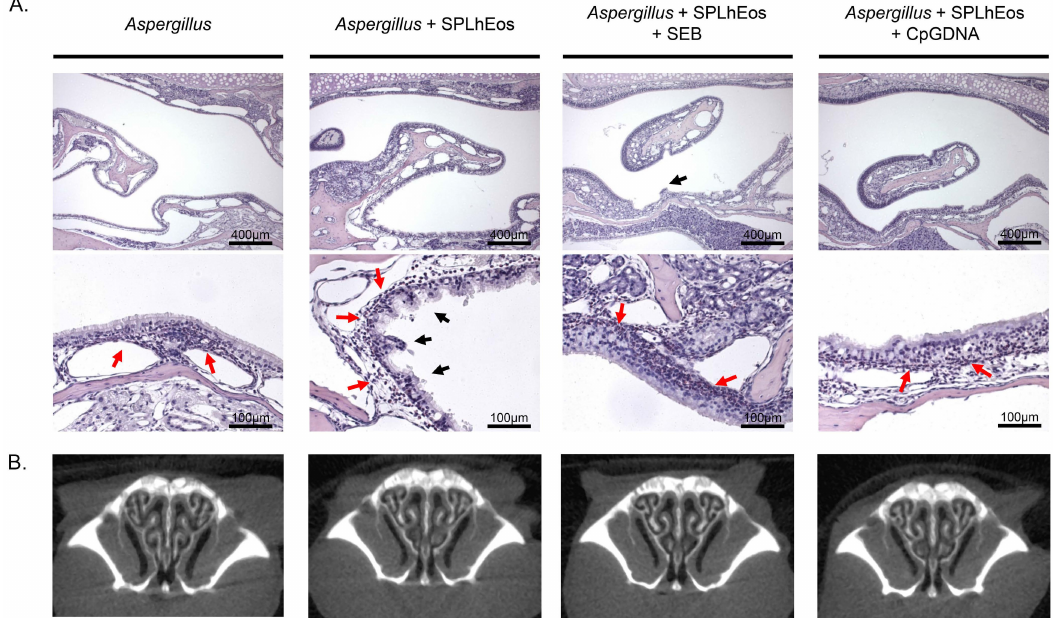
Figure 4. Histological ( A ) and CT ( B ) analyses on the transfer of SPLhEos with Aspergillus . Transfer of Aspergillus alone, Aspergillus with SPLhEos (4 × 10 7 cells), Aspergillus with SPLhEos (4 × 10 7 cells) plus Staphylococcus aureus enterotoxin B (SEB), or Aspergillus with SPLhEos (4 × 10 7 cells) plus DNA containing unmethylated CpG motifs (CpGDNA) were grouped into the adoptive transfer system ( n = 5 mice per group). Subfigures ( A , B ) indicate Sirius-red-stained histological sections and coronal images taken by CT scans in the paranasal sinus,